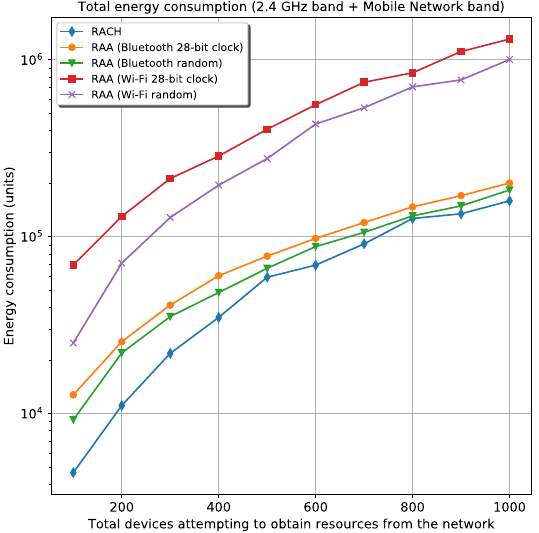
Figure 11. Total energy spent for all devices registration in all bands when there are 1000 connected devices to the mobile network before the new requesters start attempting to obtain resources from the network for the classic RACH and four di ff erent RAA